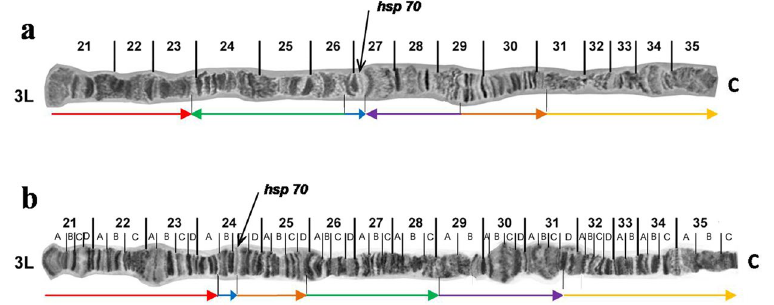
Figure 4. Comparison of the 3L polytene chromosome arms of Ceratitis fashiventris and Ceratitis capitata . ( a ) The 3L polytene chromosome arm of C . fasciventris ; ( b ) The 3L polytene chromosome arm of C . capitata . Horizontal arrows of the same color show the position and relative orientation of the putative corresponding chromosome segments between the two species. Vertical black lines underneath the chromosomes show the proposed breakpoints. Black arrows indicate the hybridization site of the hsp70 probe in each species. C indicates the centromere.